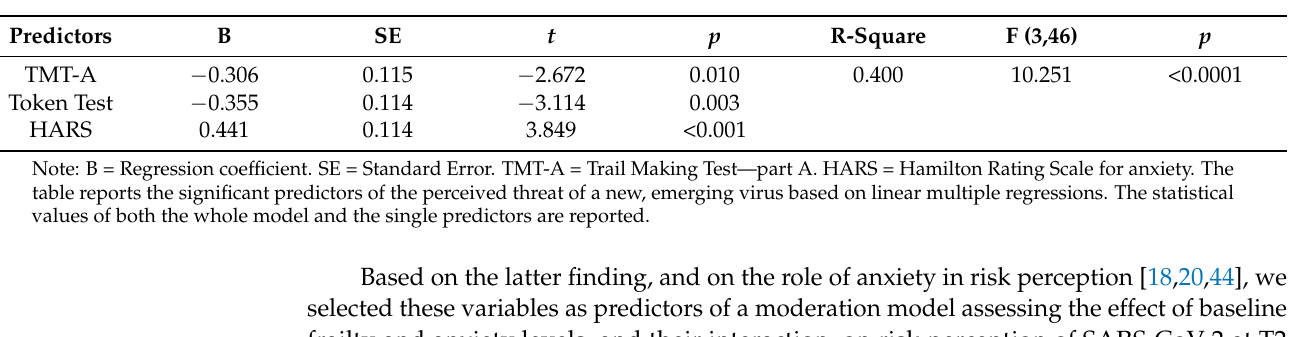
Table 6. Multiple linear regression analysis for predicting the perceived threat of a new, emerging virus